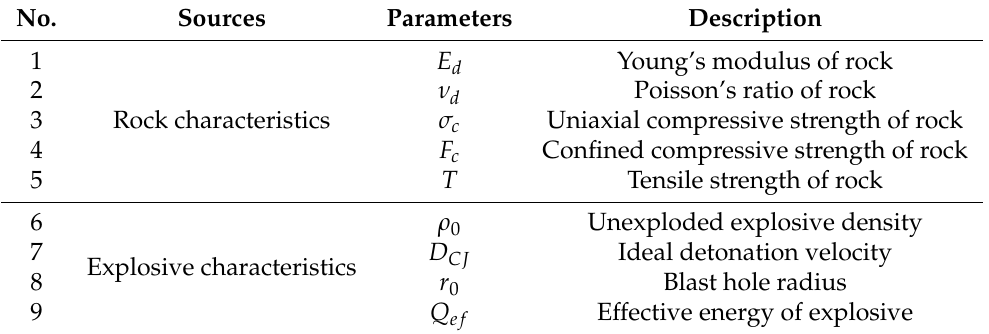
Table 1. Main parameters involved in explosion-induced rock